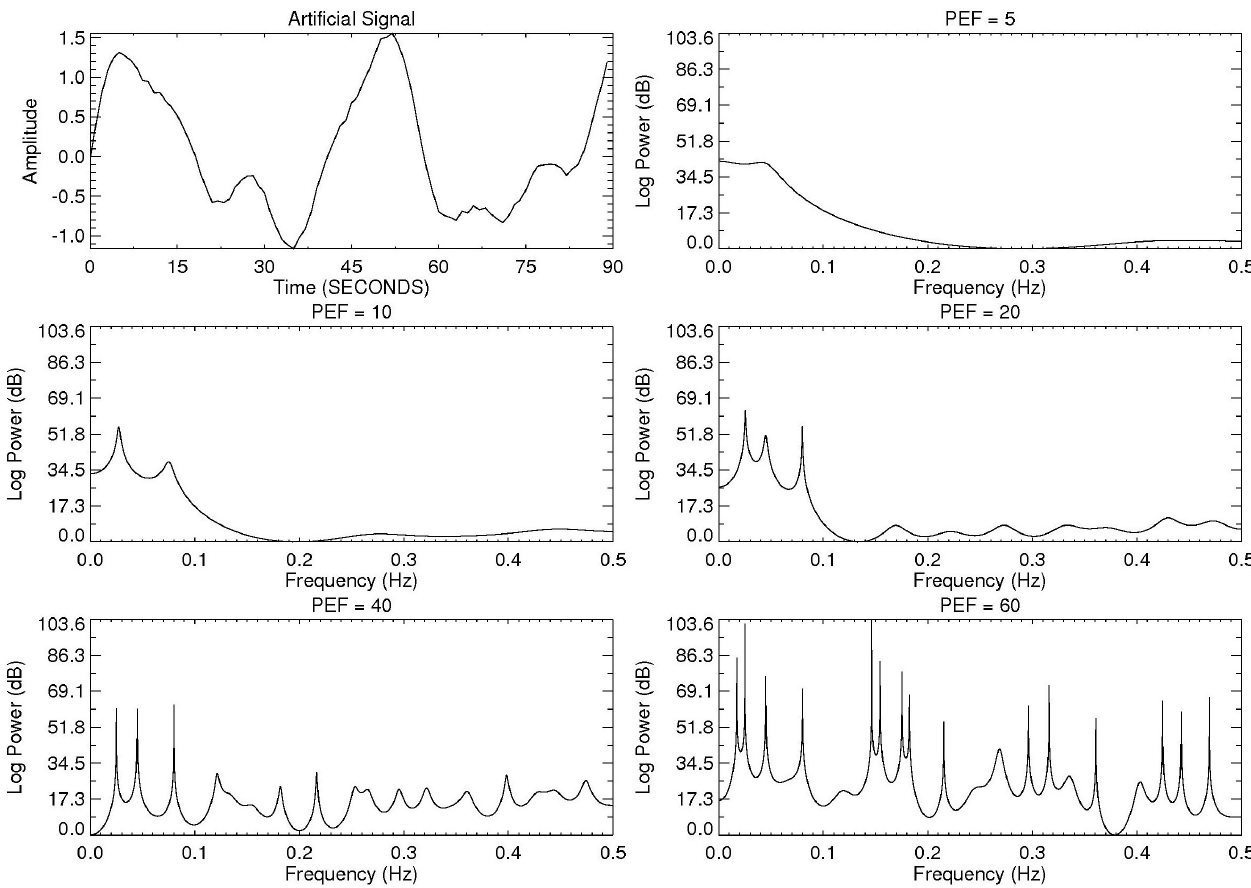
Fig. 1b. MESA spectral estimates of a 90s test signal consisting of three sinusoids with 5% random noise.